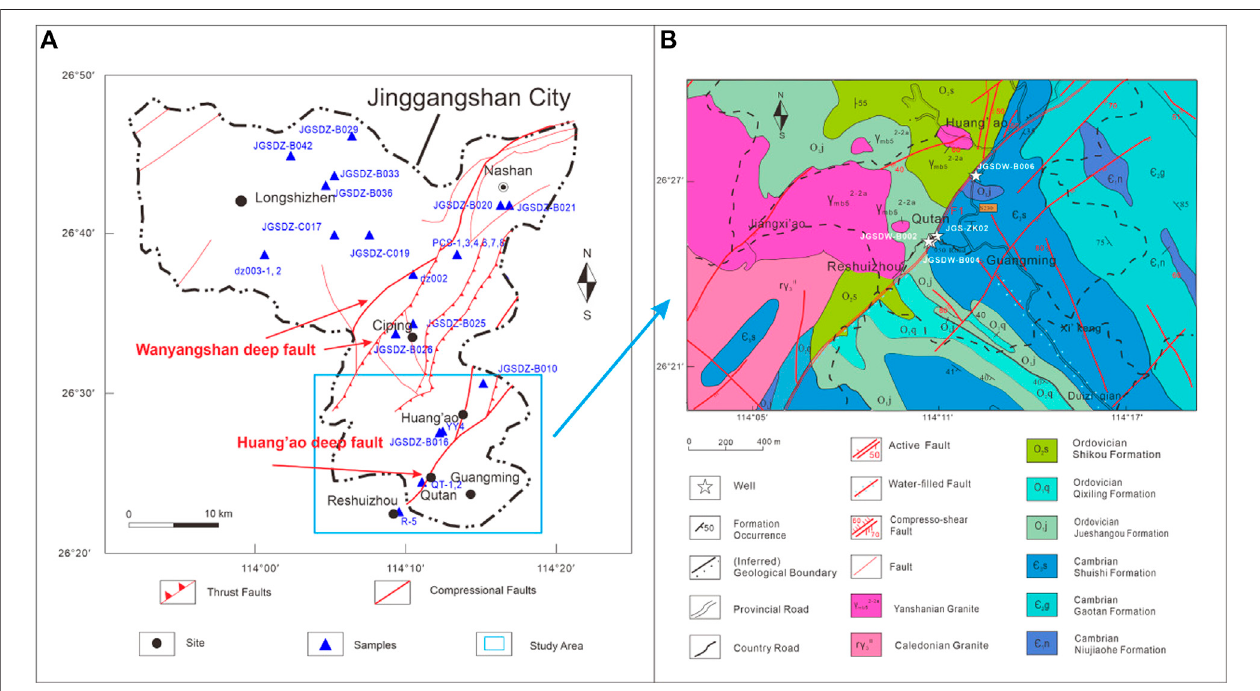
FIGURE 2 | Schematic geological map of Jinggangshan area and distribution of sampling